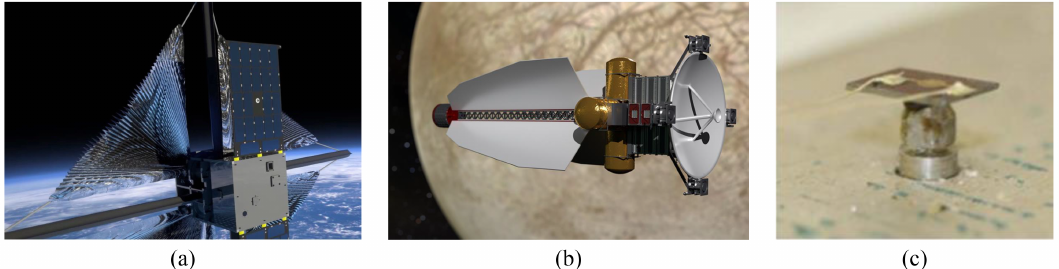
Figure 14. Examples of alternative approaches: ( a ) Advanced Composite Solar Sail System (ACS3), solar sail size ≈ 80 m 2 credits: NanoAvionics/NASA, ( b ) Swarm-Probe Enabling ATEG Reactor, or SPEAR, concept image credits: Troy Howe, and ( c ) Porous silicon thruster and sensor designed at the University of Maryland which is 2 mm total size credits: W.A.